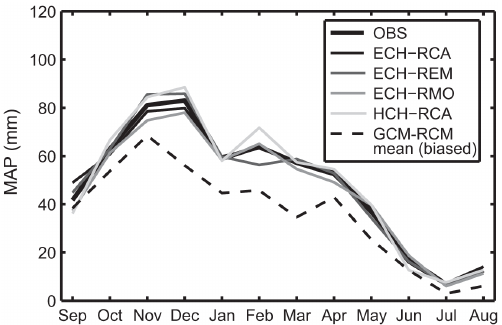
Figure 3. Illustration of the local-scale bias correction. Black line: climatological monthly average of the MAP in the RMB observed by 13 rain gages over 1951–2008. Black dashed line: MAP aver- aged across the four CMs during the same period before the bias correction. Gray shades, continuous lines: MAP of the four CMs after removing the